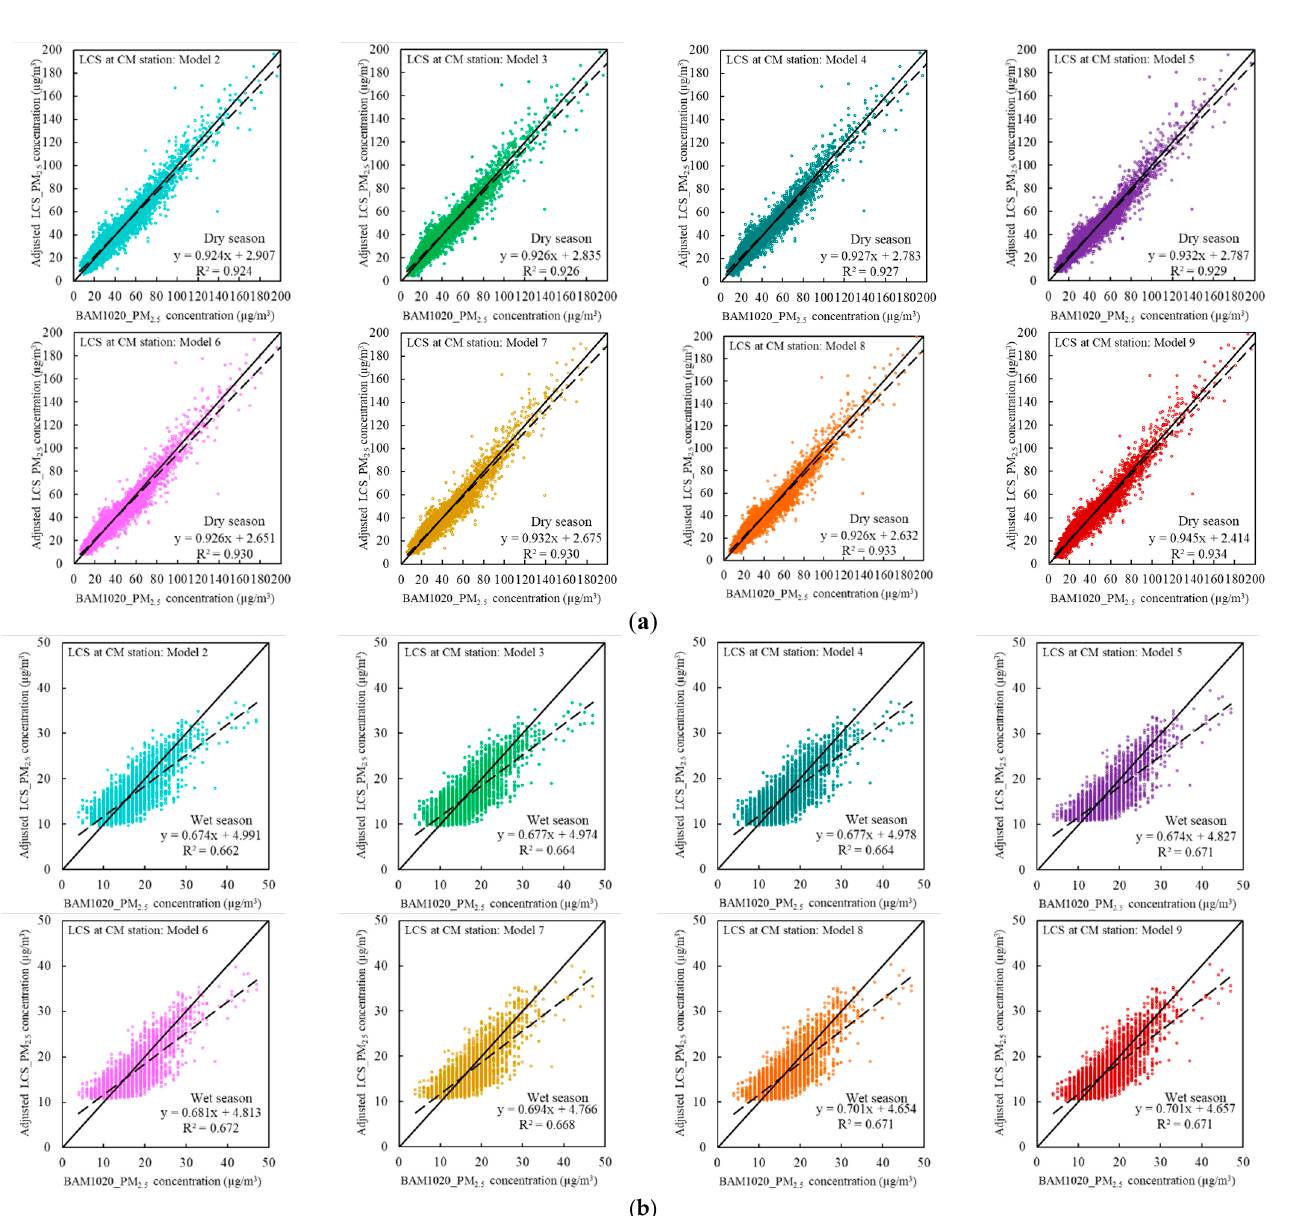
Figure A1. Correlation of 1-h PM 2.5 concentration between adjusted LCS by MRL models vs. FEM during the ( a ) dry and ( b ) wet seasons at CM. The solid line is the line with slope =1 while the dashed line represents the fitting.